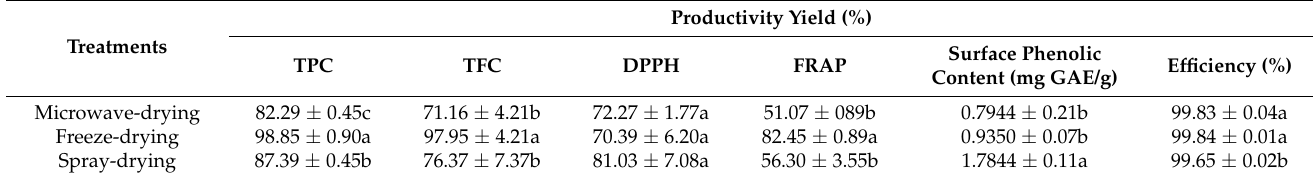
Productivity Yield (%)